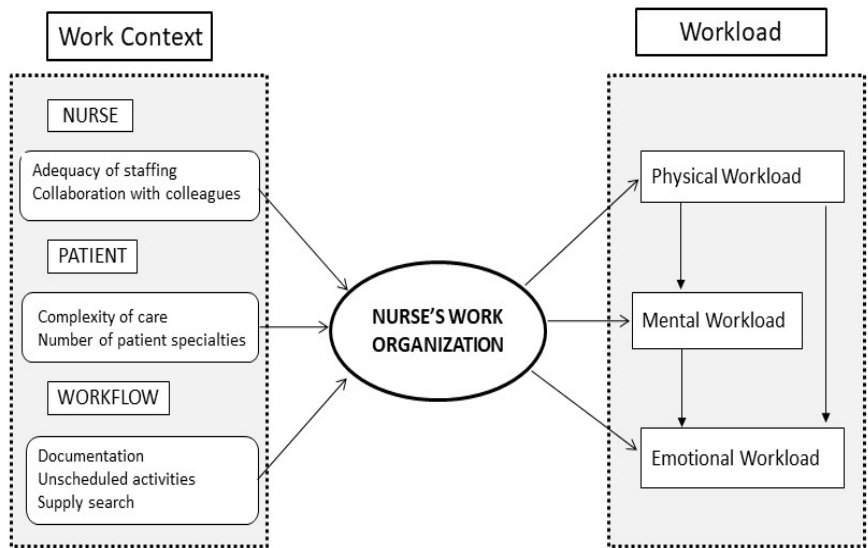
Figure 1. Conceptual model of the study.